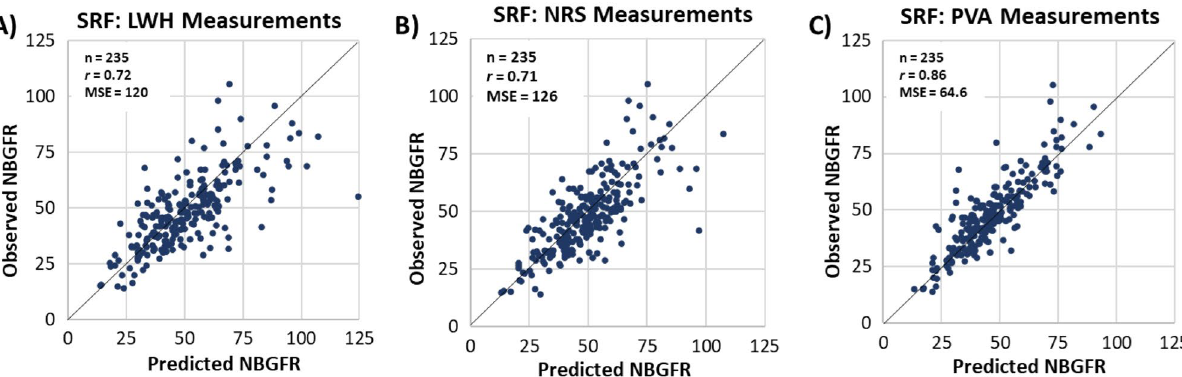
Figure 3. Correlation between predicted and observed new baseline GFR (NBGFR) after radical nephrectomy (RN). Comparison of observed and predicted NBGFR after RN based on split renal function (SRF) derived from A ) Linear length/width/height (LWH) measurements, B ) Nuclear renal scans (NRS), and C ) Parenchymal volume analysis (PVA). The SRF-based model for obtaining predicted NBGFR was (1.25 × Global GFR Pre-RN × SRF contralateral ). Correlation coefficients ( r ) and mean-squared errors (MSE) that describe the predictive accuracies for each approach are provided. SRF derived from linear LWH measurements ( p value) Ϯ SRF derived from nuclear renal scan (NRS)